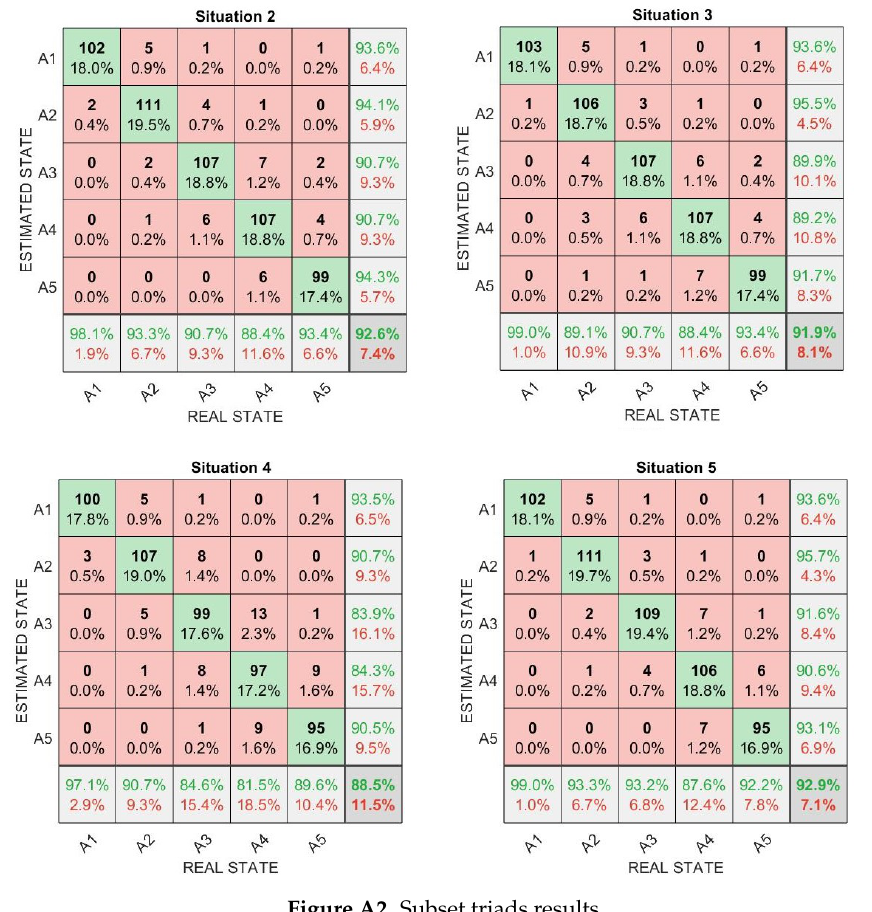
Figure A2. Subset triads results.